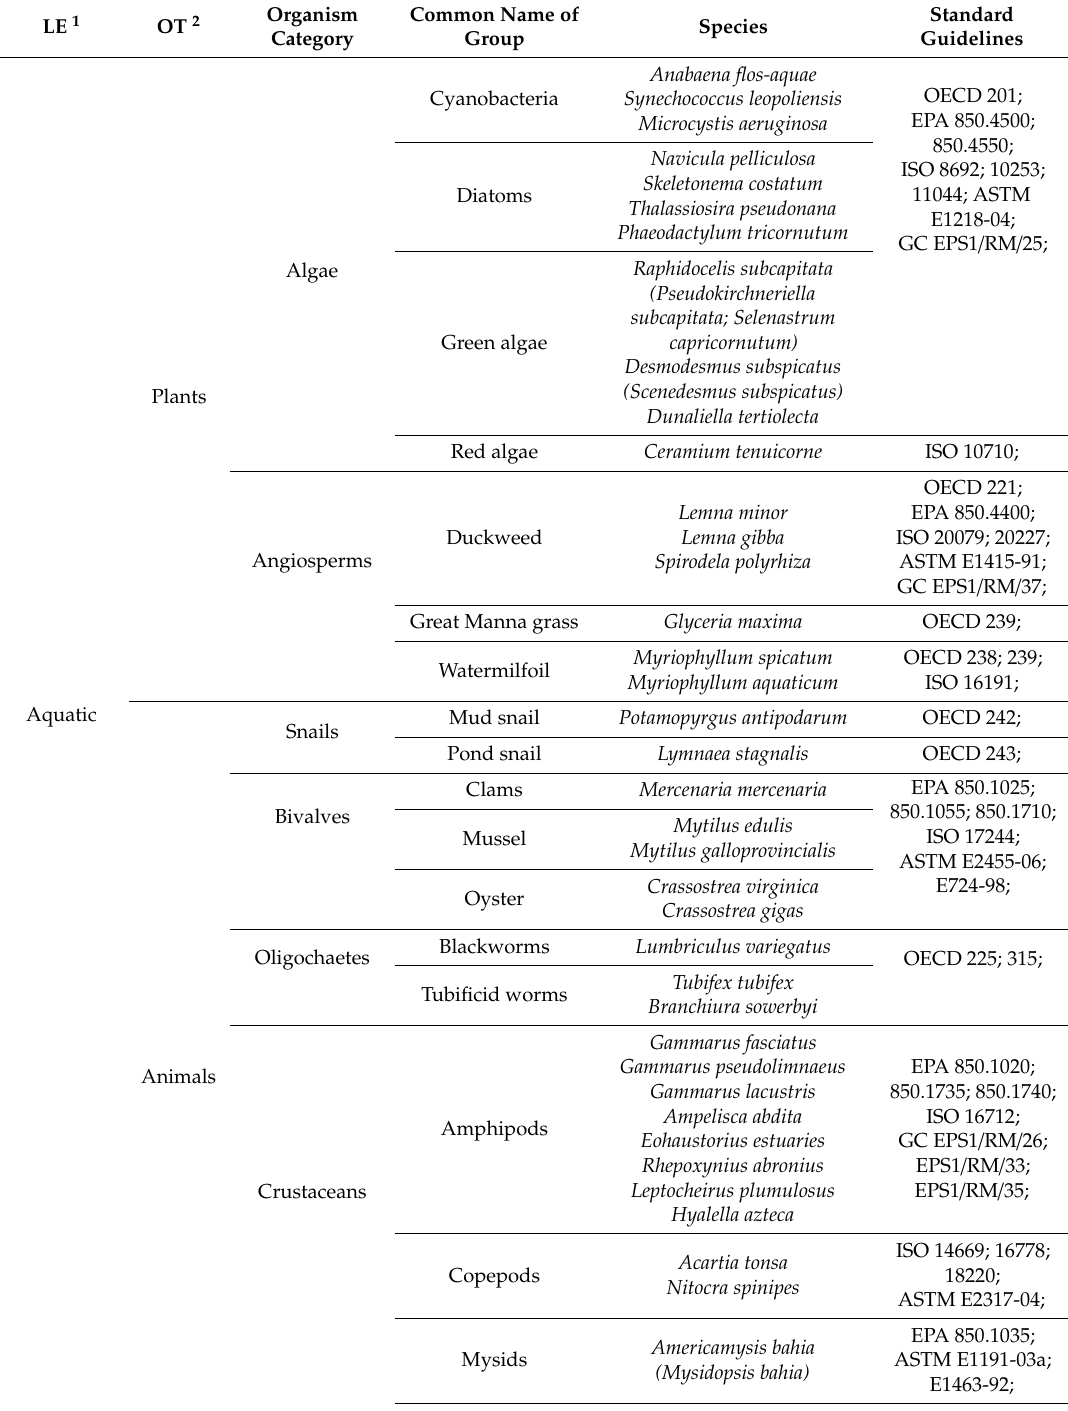
Table 2. Algae, plants and invertebrates used in standard ecotoxicity